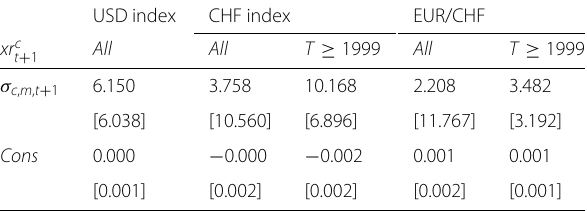
Table 9 GARCH - constant price of